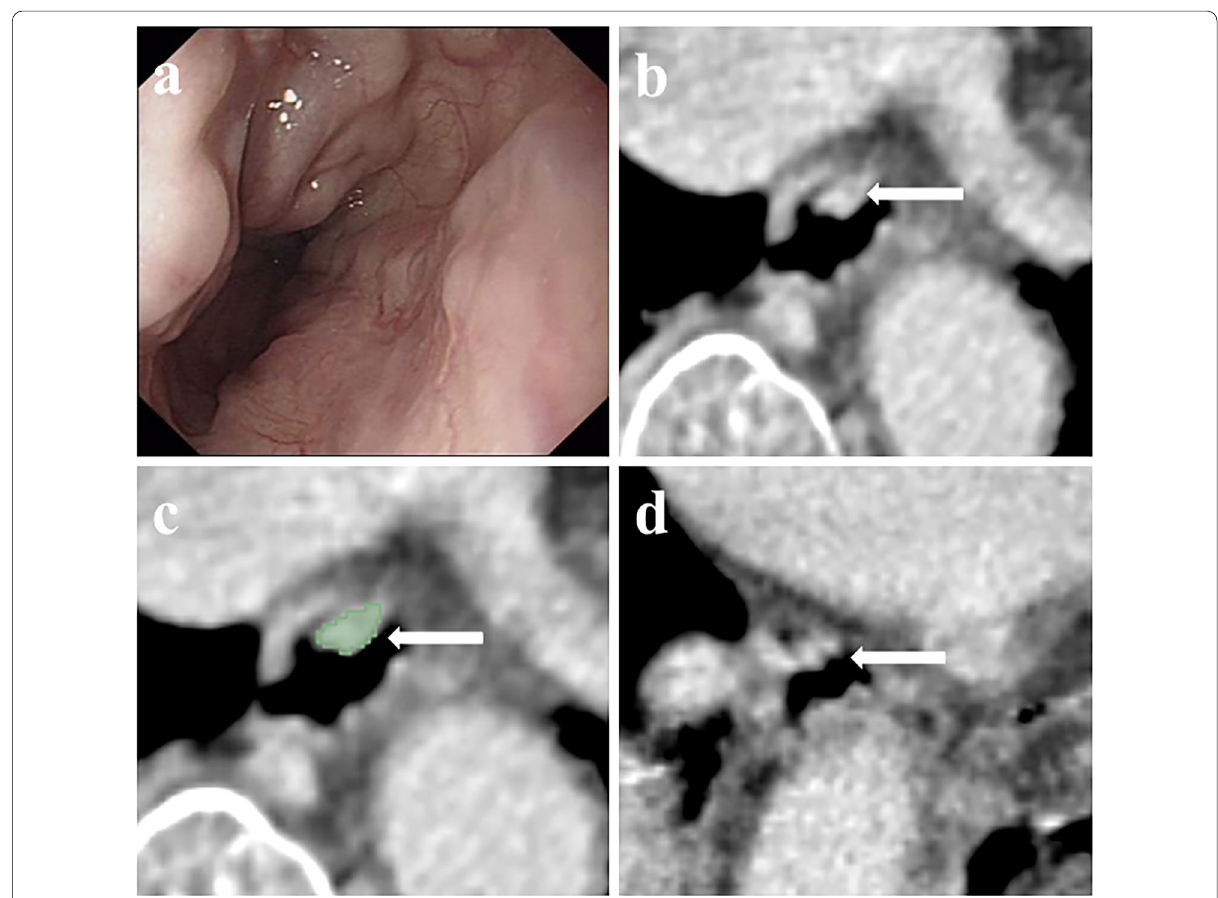
Fig. 2 Moderate EV according to endoscopy in a 74-year-old woman with liver cirrhosis (moderate of endoscopy, maximum minor axis 4.23 mm). a The endoscopic image showed tortuous dilation of varices protruding from the esophageal wall (arrow); b The cross-sectional surface area (CSA) of EV in the transverse section is depicted in 3D slicer; c CSA of EV can be clearly displayed by using 3D slicer measurement tool (dyeing area, arrow); d 3D reconstruction image shows the dilated varices in the lower esophageal